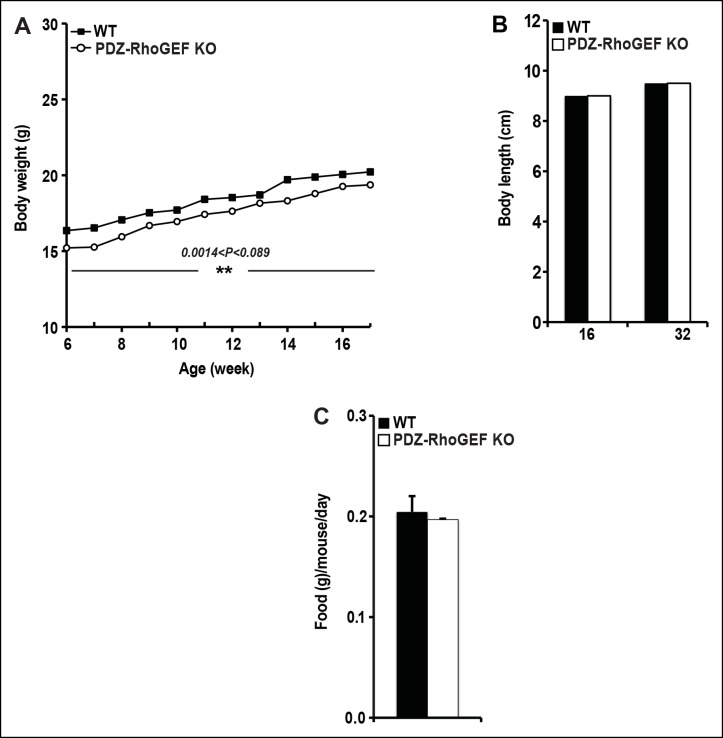
The body weight, body size, and food intake of WT and PDZ-RhoGEF KO mice.( A) Body weight of female mice on NCD (n = 12–13). (B) The size of WT and PDZ-RhoGEF KO male mice determined by measuring the length from tip of nose to anus at 16 weeks (n = 6–7) and 32 weeks of age (n = 7–11). (C) Food intake in WT and PDZ-RhoGEF KOmalemice (n = 5). Food intake per mouse was measured every two days over 15-day period. Statistical significance was calculated by a Student’s t test using Excel software (*p<0.05, **p<0.01, ***p<0.001).